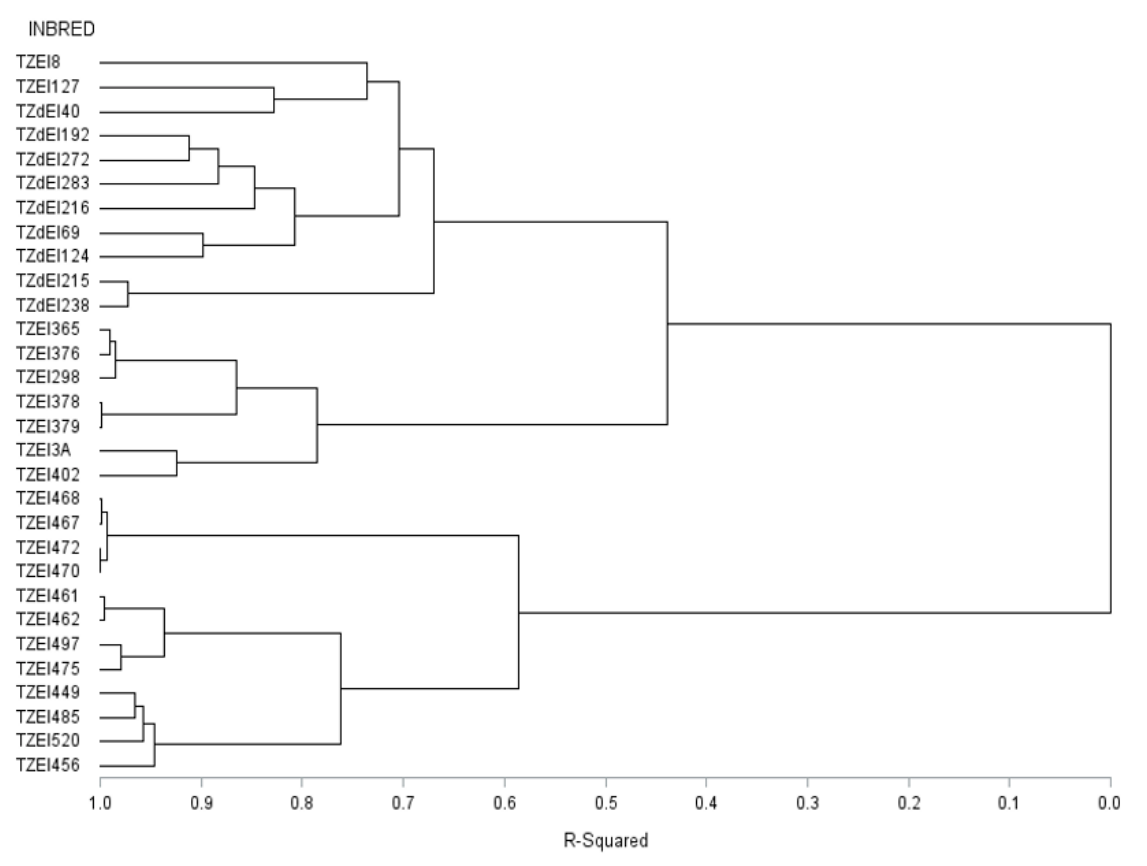
Figure 4. Dendrogram of thirty early maturing maize inbred lines obtained using Ward’s minimum variance clustering method based on 15,047 SNP markers. Table 5. Heterotic groups of the thirty early maturing maize inbred lines based on the HGCAMT and SNP-GD methods under individual and across contrasting environments.